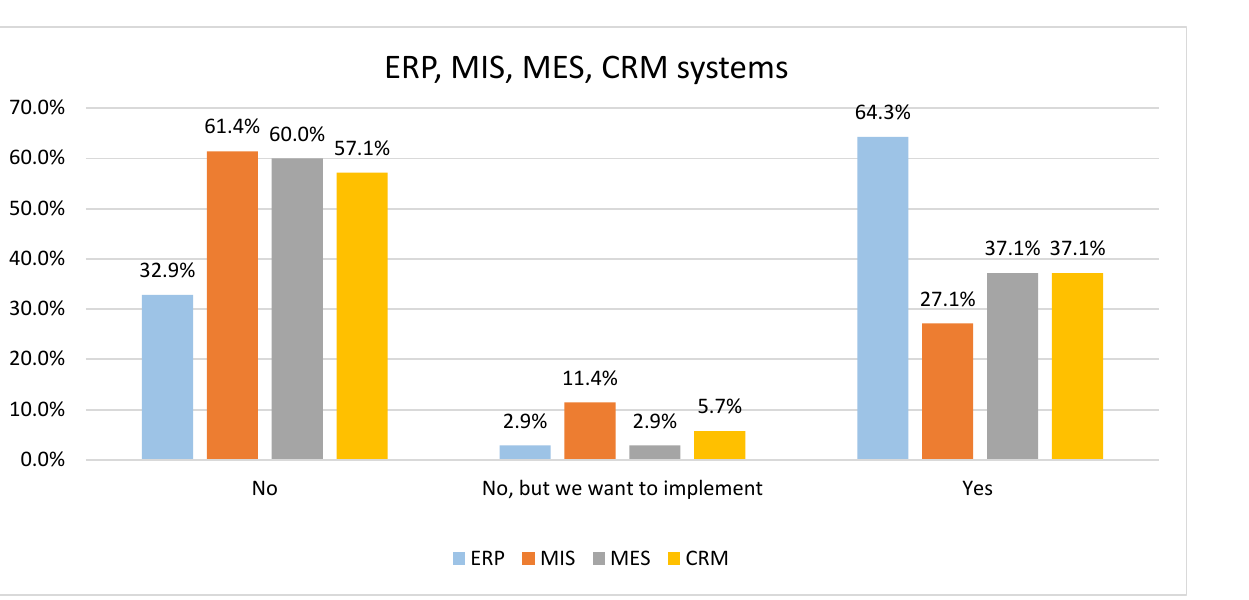
Figure 10. ERP, MIS, MES, CRM systems in the production companies. To compare data obtained from production and non-production companies, we have performed the Chi-Square Test. Based on the results obtained, we have concluded that there is no statistically justified difference in the strategy of implementing MIS and CRM systems ( p -value equals 0.486 and 0.392, respectively). However, there is a difference in the strategy of implementing ERP and MES systems ( p -value equals 0.000). For example, 41 production companies declared that they have implemented an ERP system, and 25 have an MES system. In comparison, only 4 non-production companies have an ERP sys- tem, and one company has an MES system.